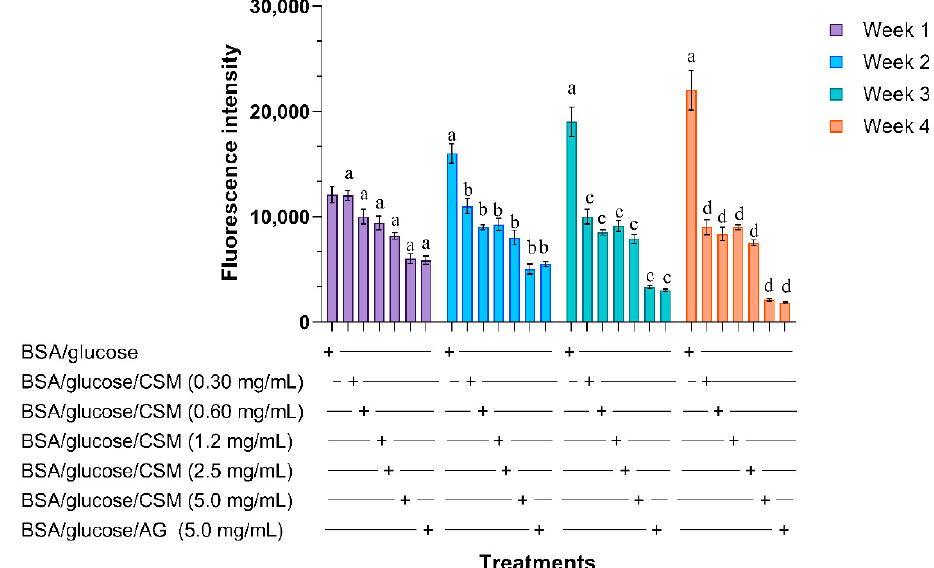
Figure 1. Effects of CSM extract on formation of fluorescent advanced glycation end products (AGEs) in BSA incubated with glucose. Each value represents the mean ± SE. a p ≤ 0.05 when compared to BSA/glucose at week one; b p ≤ 0.05 when compared to BSA/glucose at week two; c p ≤ 0.05 when compared to BSA/glucose at week three; d p ≤ 0.05 when compared to BSA/glucose at week four. Different letters indicate significant differences between the weeks evaluated. CSM; methanol extract from the seed of S. purpurea , AG; aminoguanidine.